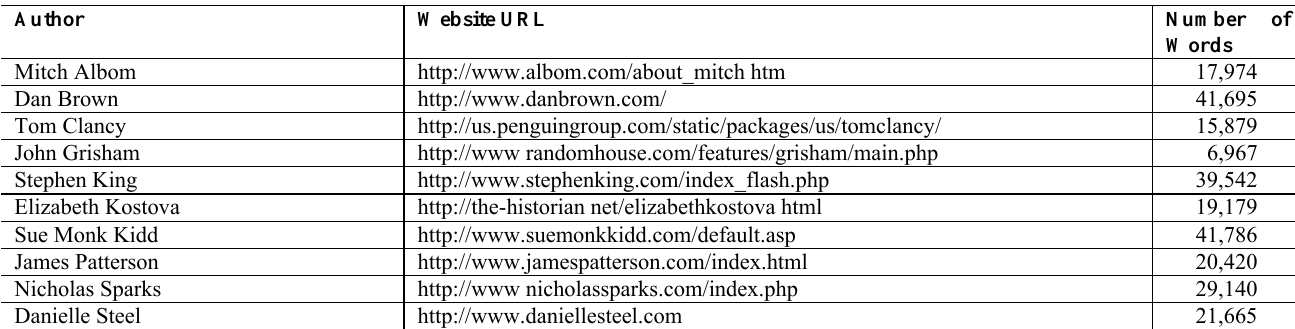
Table 1: Original sample of the investigated official authors’